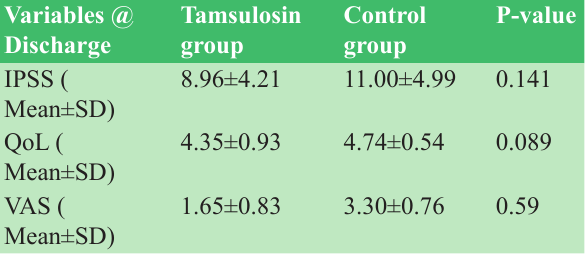
Table 2: Variables at the time of DJ